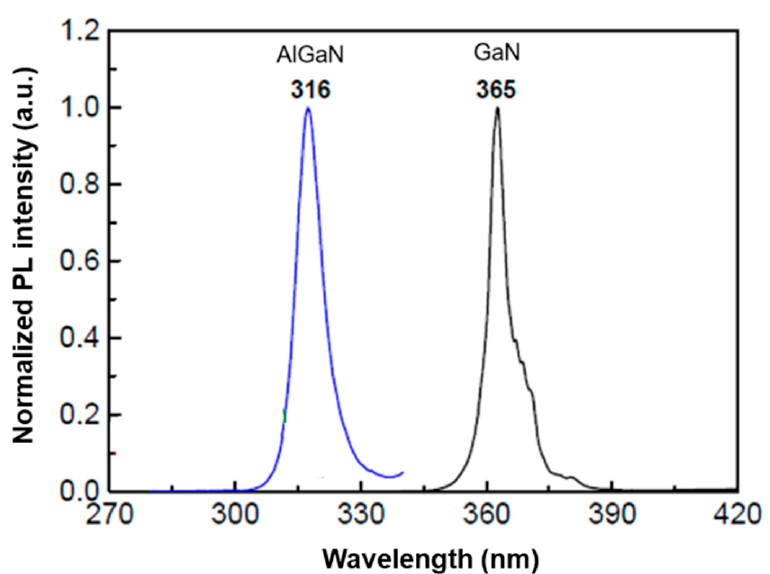
Figure 2. PL spectra of the epitaxial wafer before fabrication of the asymmetric MSM AlGaN UV sensor at room temperature.